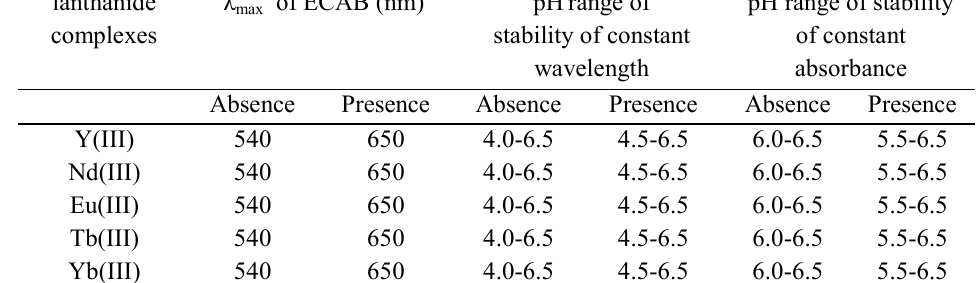
Table 3. pH range of stability of ECAB complexes in absence and presence of CDMEAB.